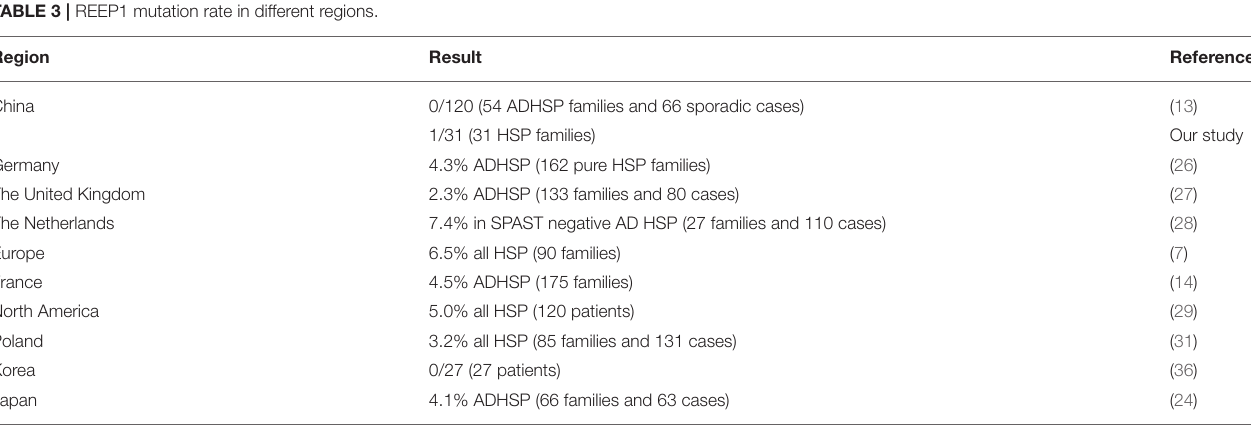
TABLE 3 | REEP1 mutation rate in different